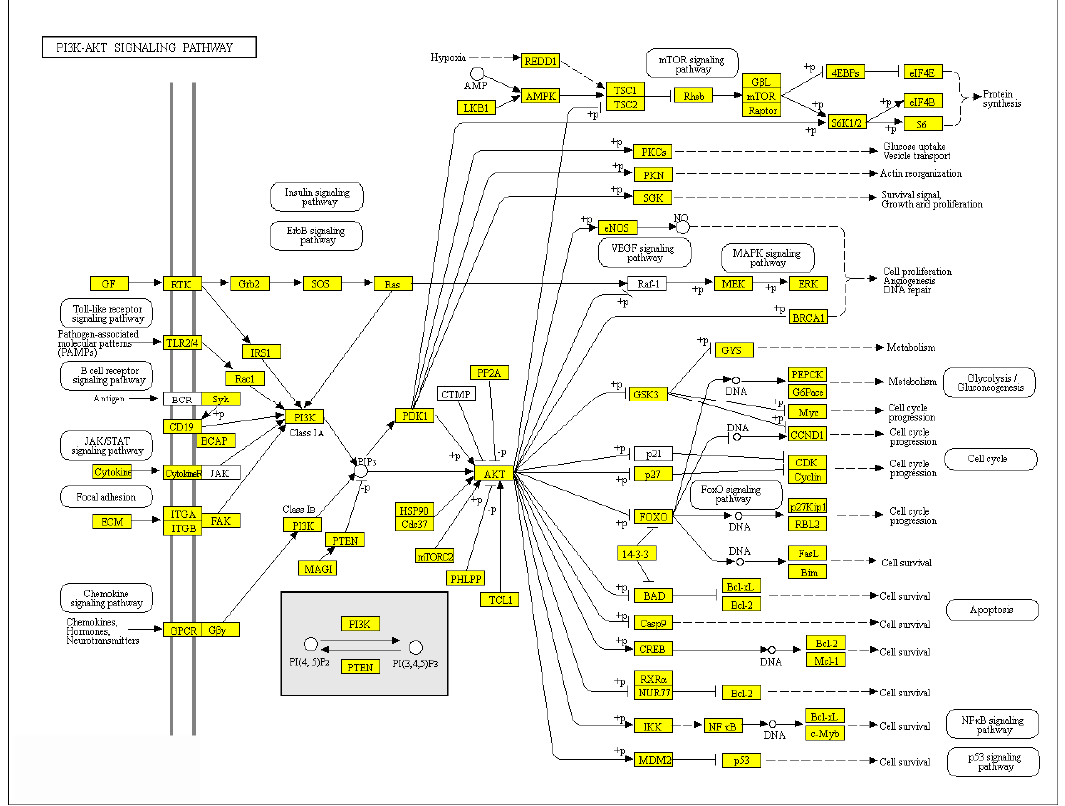
Figure 3. FoxG1 target genes mapped on the Akt pathway network. Known FoxG1 target genes are highlighted in yellow according to [6], and comprise Akt and S6, thus validating western blot data shown in Figure 2.